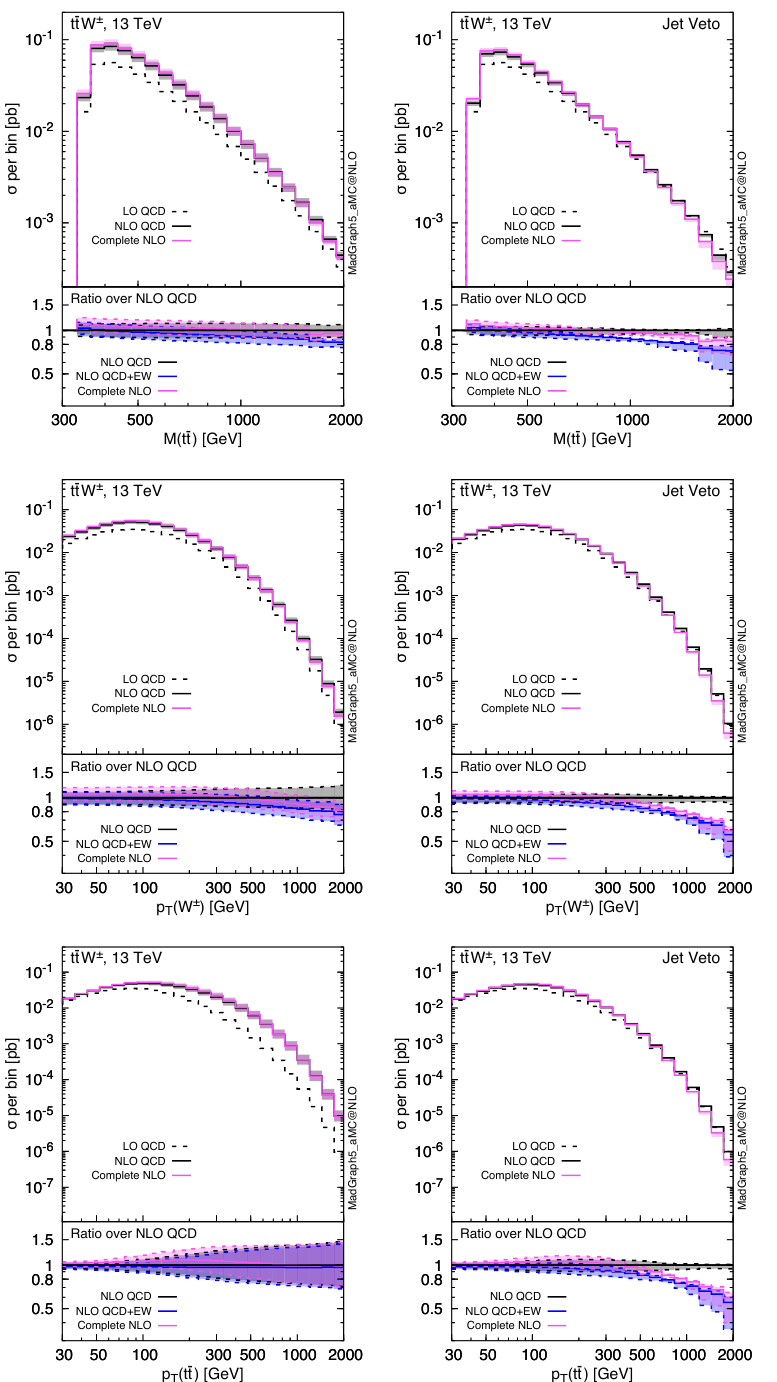
Figure 5 . Di(cid:11)erential distributions for t (cid:22) tW (cid:6) production at 13 TeV. For the plots on the right, the jet veto of eq. (3.6) has been applied. The main panels show the scale-uncertainty bands for LO QCD + NLO QCD (black) and LO + NLO (pink), and central value of LO QCD ; in the lower inset the scale-uncertainty bands are normalised to the LO QCD + NLO QCD central value and also the LO QCD + NLO QCD + NLO EW prediction (blue) is displayed.